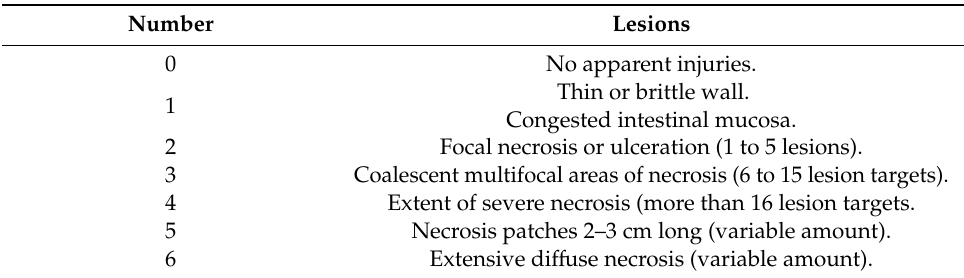
Table 4. Scale of gross lesions in the small intestine with chronic enteritis. Number Lesions 0 No apparent injuries. Thin or brittle wall. 1 Congested intestinal mucosa. 2 Focal necrosis or ulceration (1 to 5 lesions). 3 Coalescent multifocal areas of necrosis (6 to 15 lesion targets). 4 Extent of severe necrosis (more than 16 lesion targets. 5 Necrosis patches 2–3 cm long (variable amount). 6 Extensive di ff use necrosis (variable